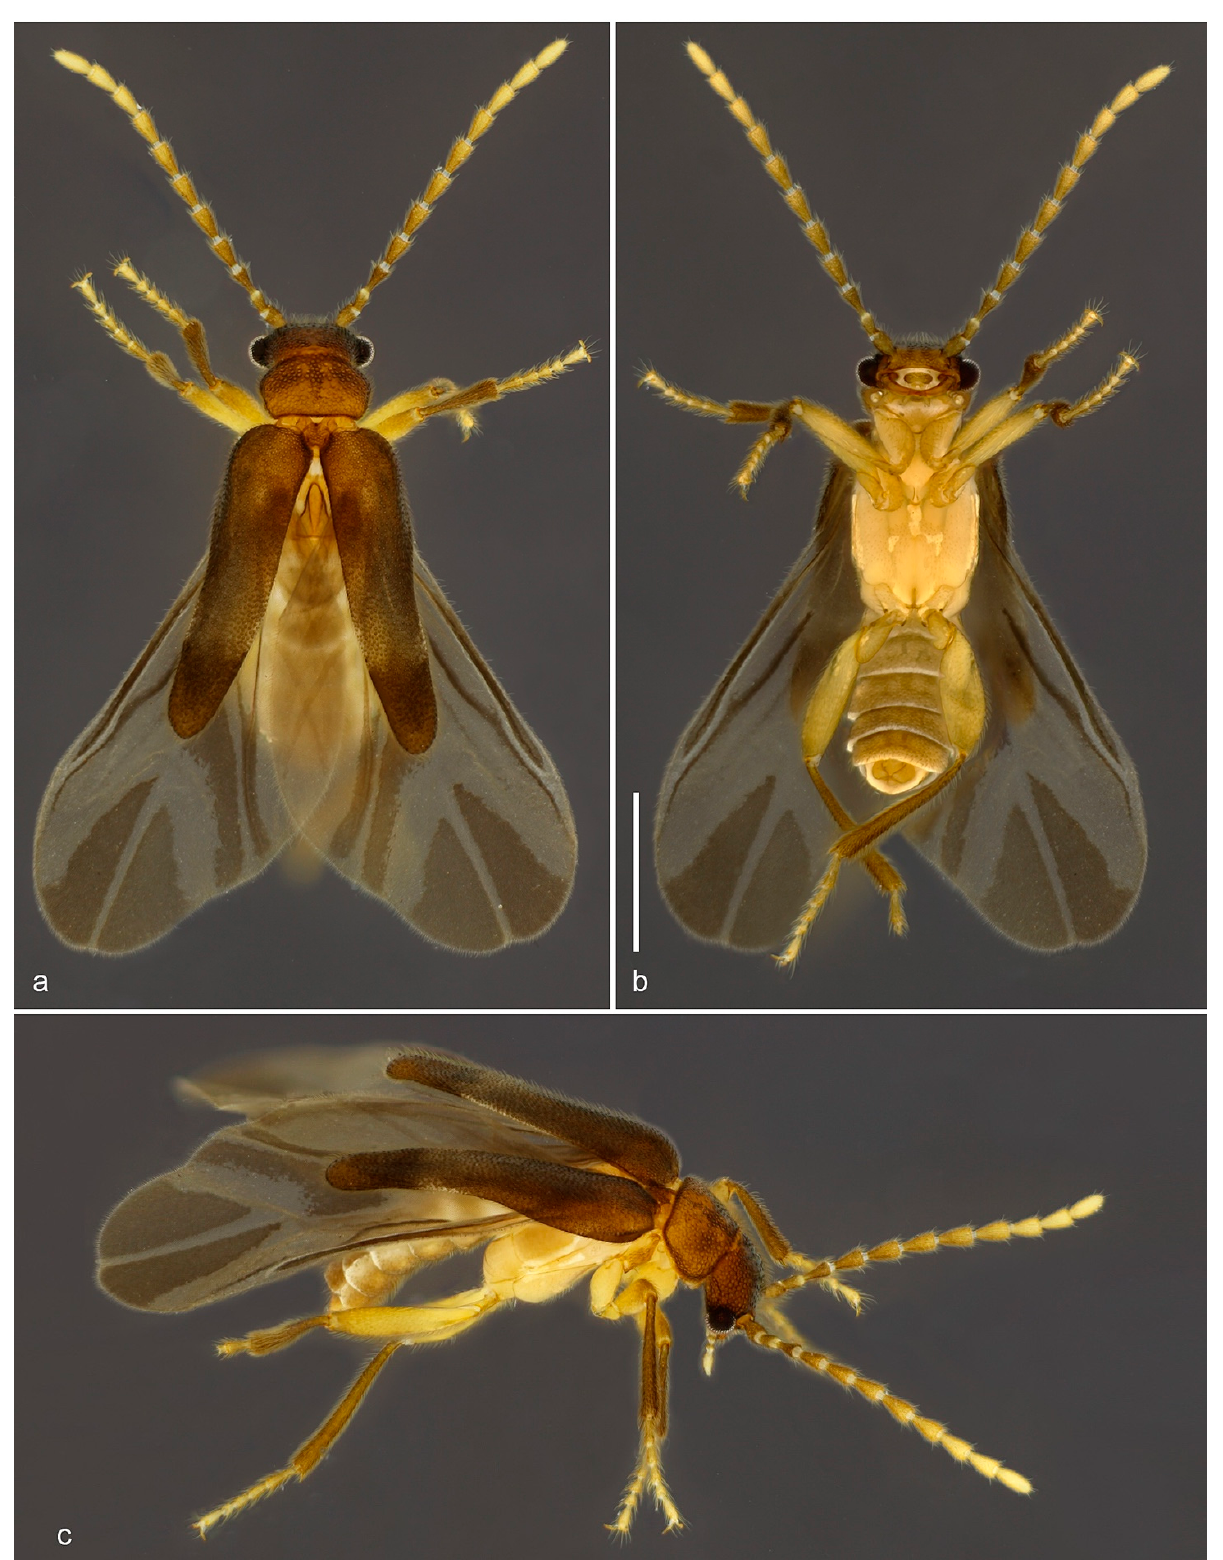
Figure 3. Jurasai vanini sp. nov., habitus. ( a ) Dorsal view; ( b ) ventral view; ( c ) lateral view. Scale bar = 1.0 mm.